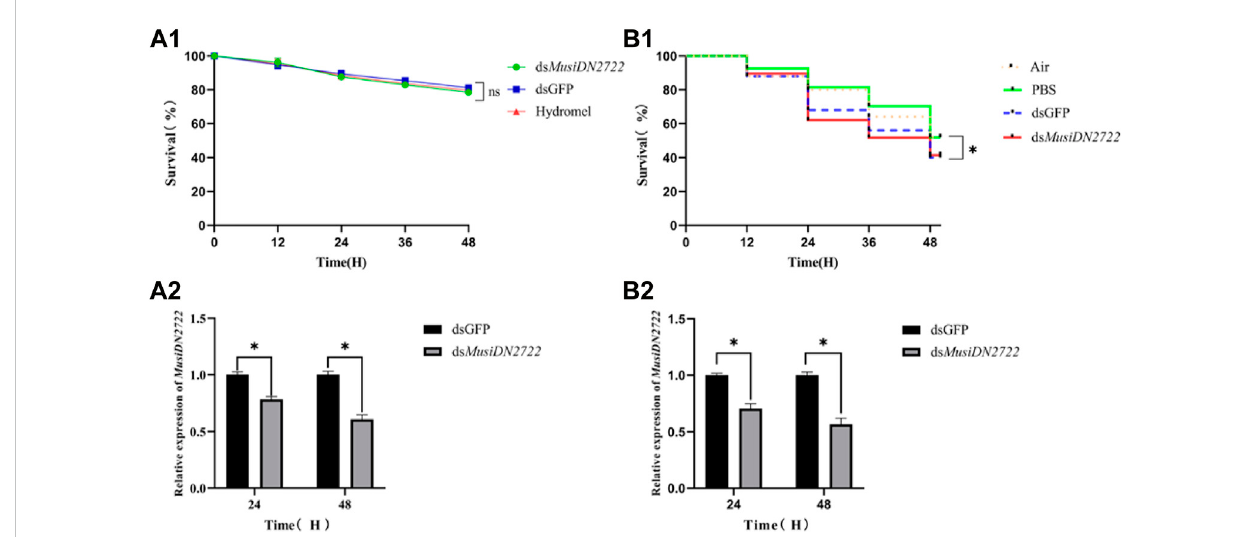
FIGURE 7 SurvivalratesafterRNAibydifferentmethodsandgeneexpressionof MusiDN2722 atdifferenttimes. (A) Feedingmethod; (B) injectionmethod.Data are represented in the form mean ± SEM. *signi fi cant difference ( p < 0.05).